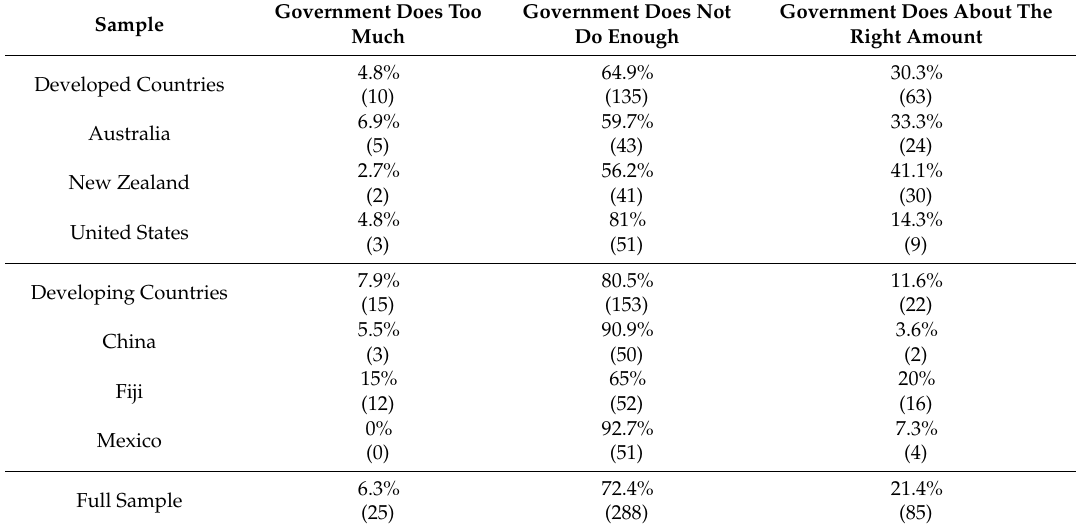
Table 10. Frequency of government e ff